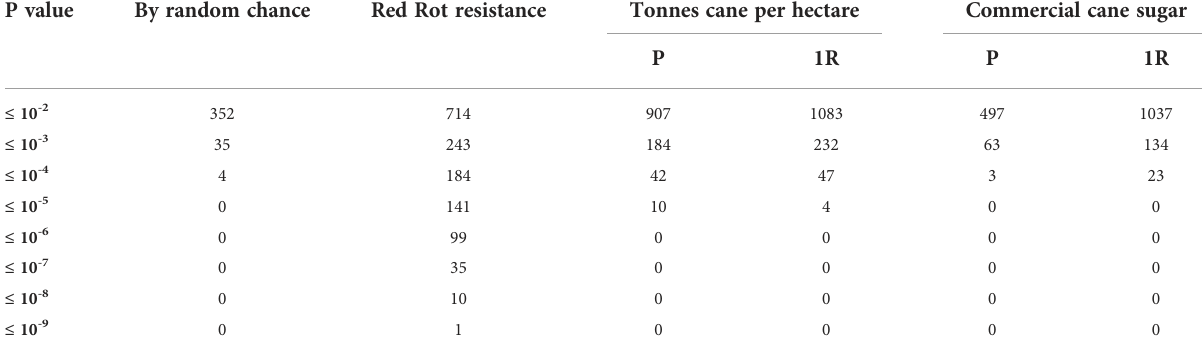
TABLE 1 GWAS results for all